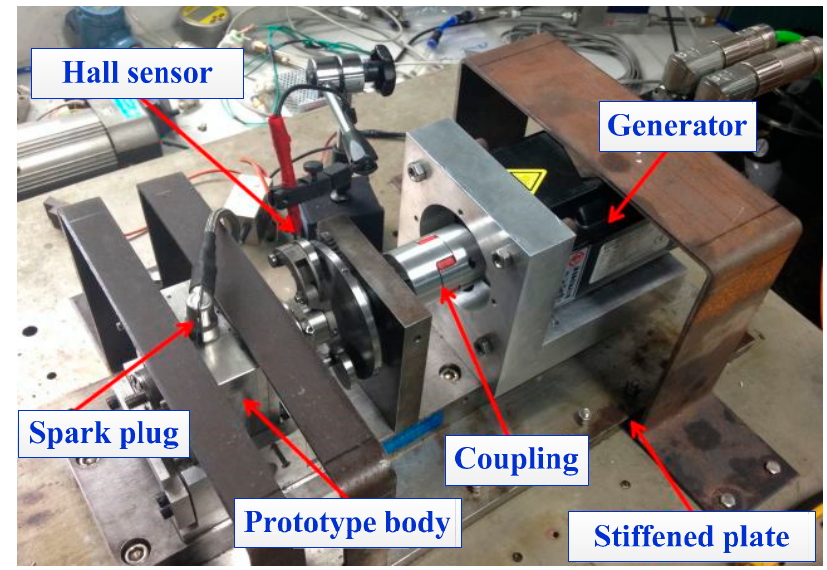
Figure 26. Prototype system in the test rig.